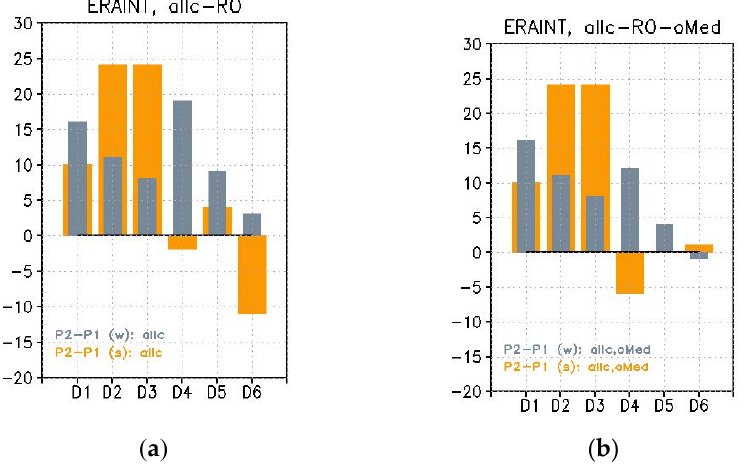
Figure 3. ( a ) Change in the total number of cyclone tracks “entering” the Di sub-domains (i.e., reaching first the sub-domain, Di i = 1,6) as a difference (P2–P1) for summer (orange) and winter (grey); ( b ) the same for only cyclones with origins over the Mediterranean Sea (“Med” domain origins).